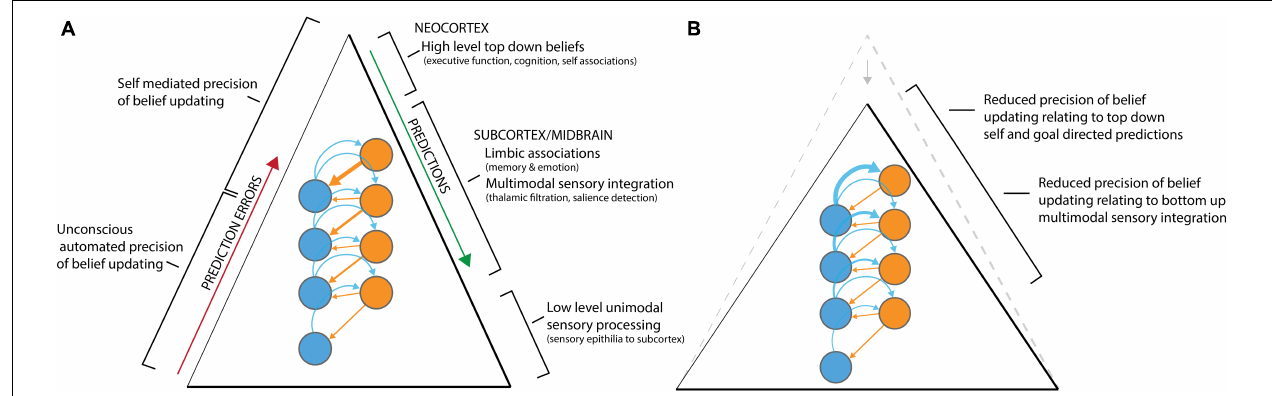
FIGURE 2 | Simplified illustrative description of precision of belief updating along the cortical hierarchy. (A) Precision is represented along scales of the hierarchy and depicts the filtration of sensory impressions to cognition. Predictions and prediction errors can be seen to interact between each layer of the hierarchy, with stronger high-level predictions in the upper levels of the hierarchy. (B) Under psychedelics the precision of belief updating in high level predictions, involved in phenomenal consciousness and narrative self, is reduced. This occurs by belief updating opening alternate hypotheses that undergird neuronal populations “confidence” in the selection, and salience, of attention that integrate phenomenal consciousness and narrative self-identity. Reduced precision is represented by the reduced weight of predictions and increased influence of prediction errors in higher levels of the hierarchy where 5-HT2A receptors are abundant. The change to the precision of belief updating is hypothesized to result in ego dissolution. Elements of this model are inspired by Carhart-Harris and Friston